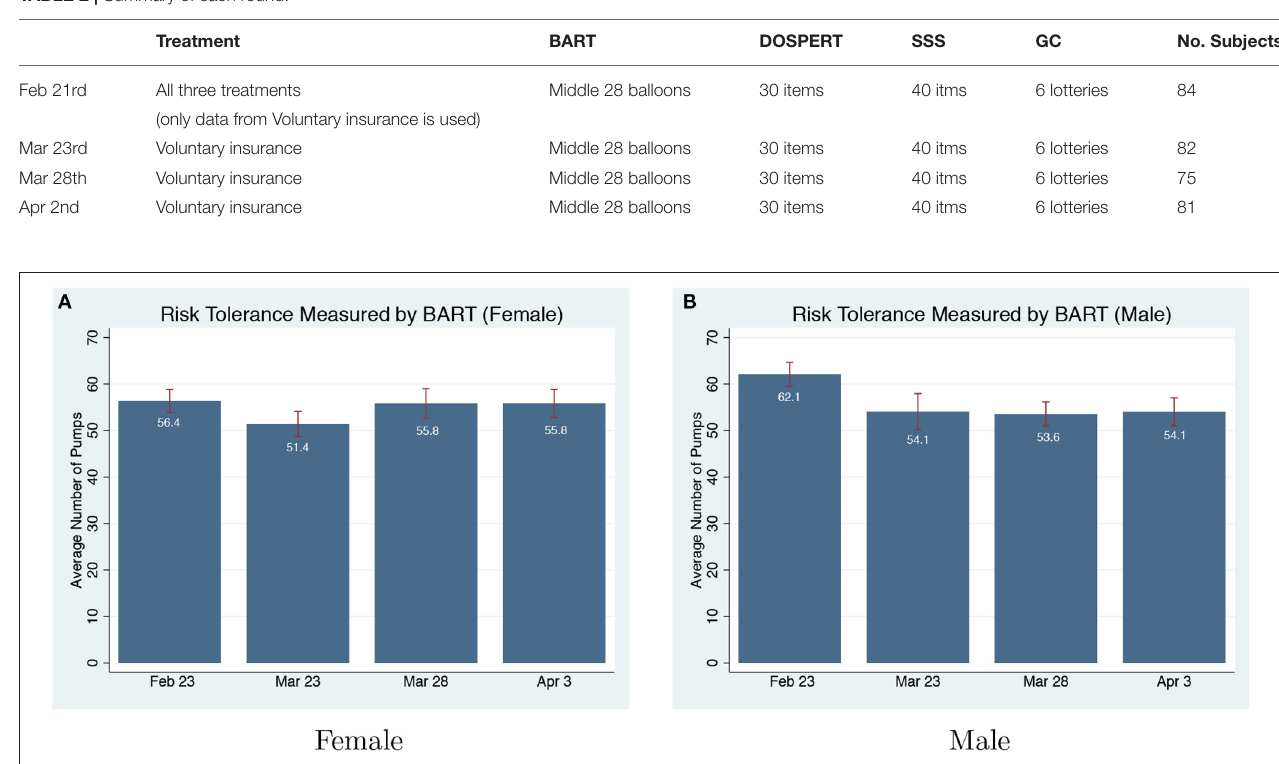
TABLE 2 | Summary of each round.